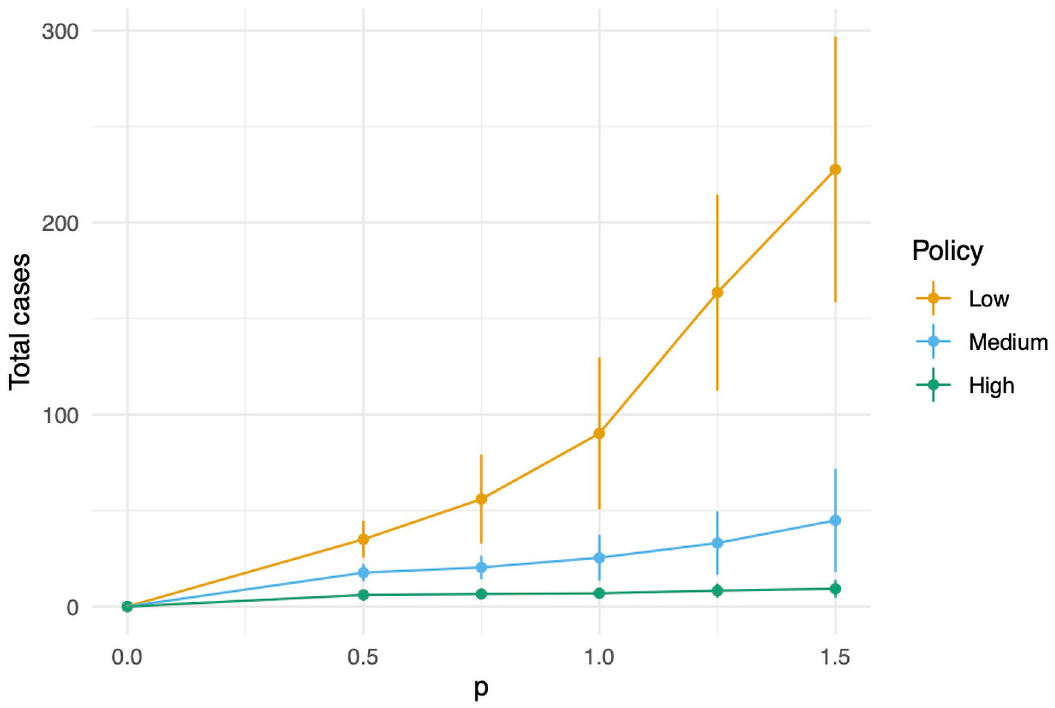
Fig 10. A sensitivity analysis of the tuning parameter, p . We fix the student adherence to be medium, and show the total number of cases for each of the three administrative policies.